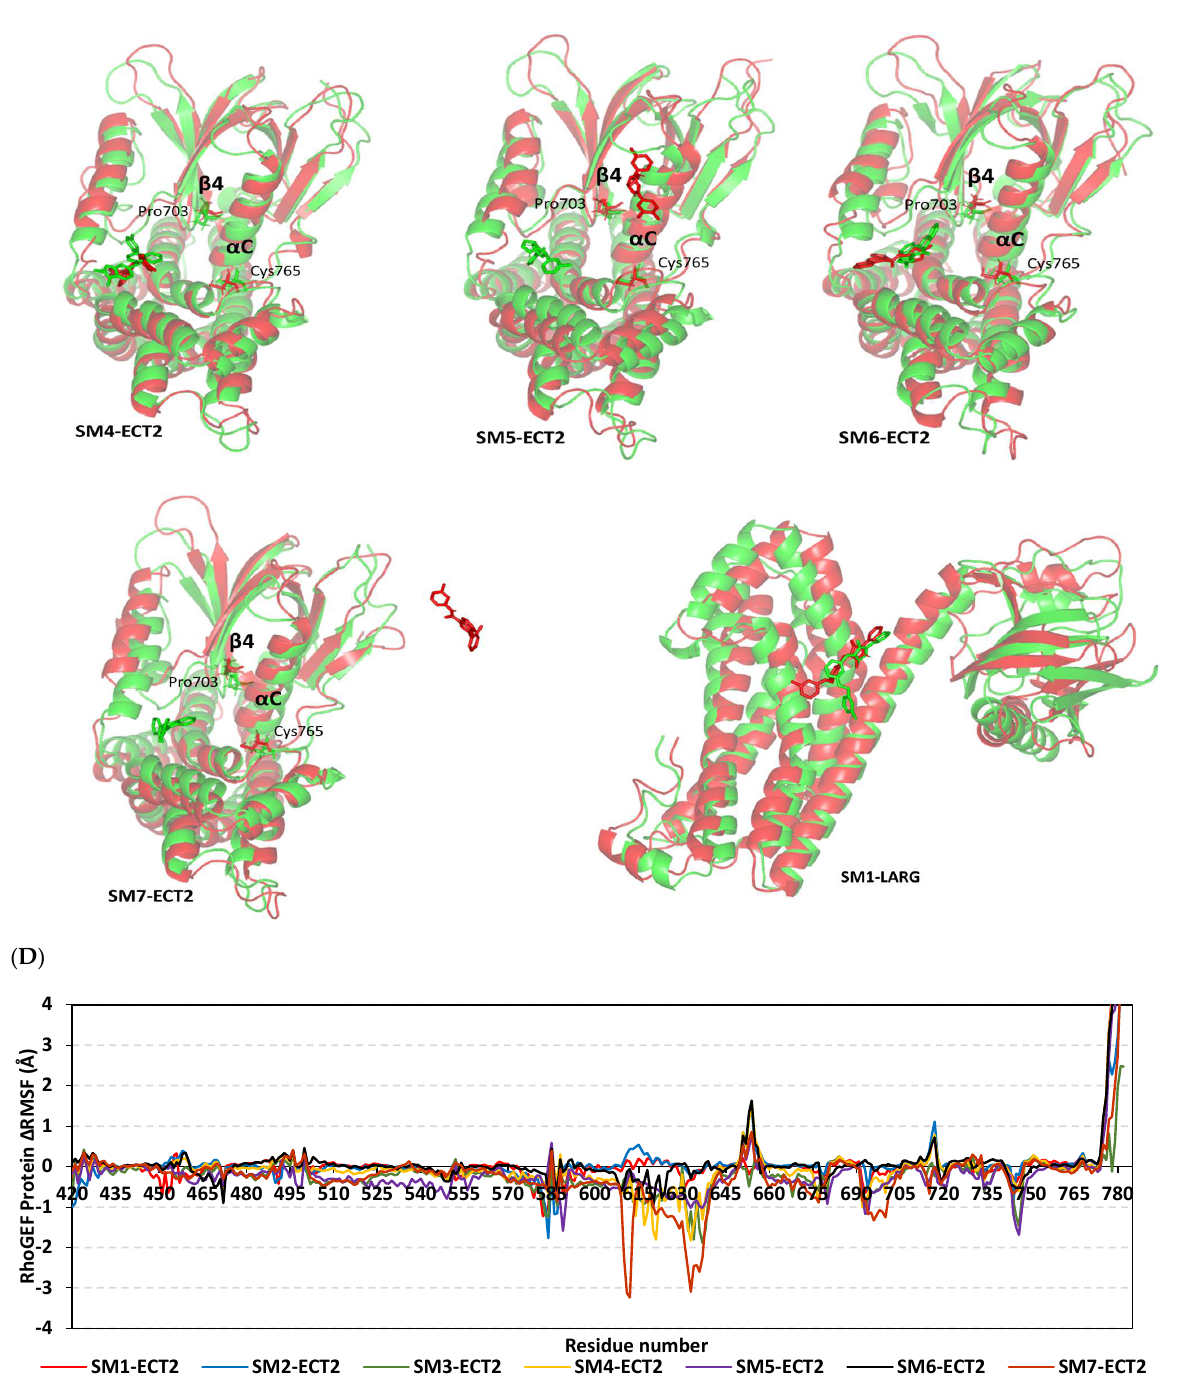
Figure 12. Thermodynamic stability of the simulated small molecules bound to RhoGEFs. ( A ) Alpha-carbon atom RMSDs for RhoGEF proteins. ( B ) Sole ligand RMSDs in relation to simulation time frames in nanoseconds (ns). ( C ) Overlaid ligand/RhoGEF trajectories at initial and final time frames. Ligands (sticks) and bound RhoGEF proteins (cartoon) are colored green and red with respect to 0 ns and 100 ns extracted frames. For ECT2 proteins, Pro703 β4-sheet tip and C-terminal Cys765 at the PH domain are annotated. ( D ) Difference RMSF (ΔRMSF) trajectories for ECT2 target proteins along the whole molecular dynamic simulations in relation to apo/unliganded state.